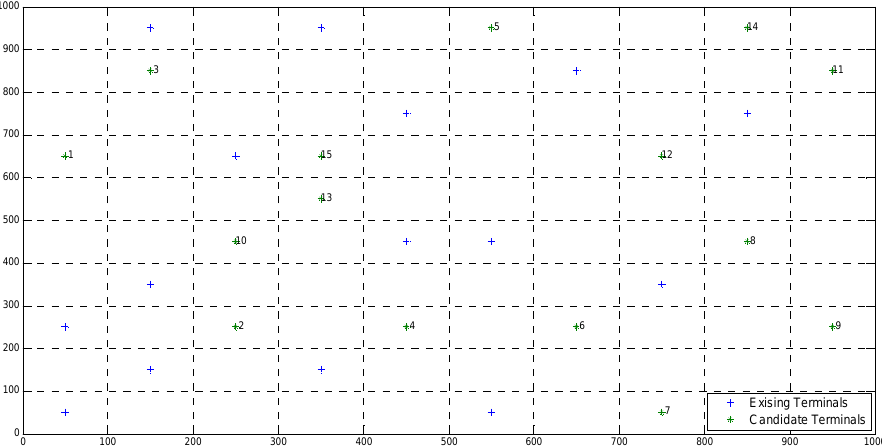
Fig. 4. Network layout for case study